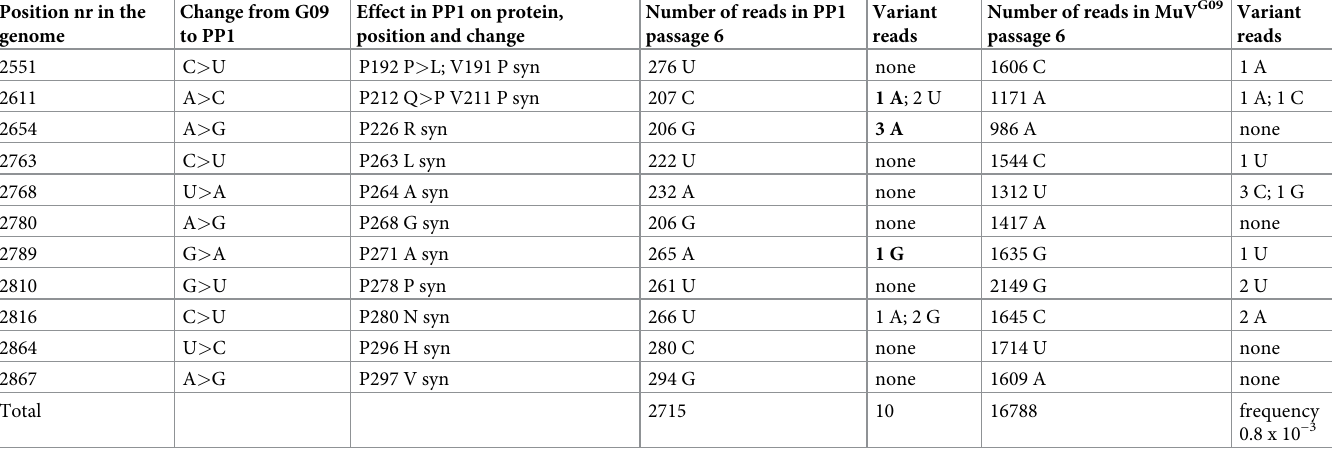
Table 1. Stability of the unique mutations in RNA extracted from semi-purified MuV–PP1 virus after 6 passages on Vero cells. Position nr in the Change from G09 genome to PP1 single well and passaging the inoculum 4 times on Vero cells at low MOI. The reverse genetics system used ‘helper’ expression plasmids representing the authentic N, P and L genes of MuV G09 and a plasmid containing the consensus sequence of MuV G09 so that fowl pox virus mediated recombination between helper plasmids and the full length genome plasmid could not lead to potential sequence alterations. Out of the 5 plaque picks that were made in the pri- mary rescue wells transfected with a plasmid representing the full length genome of MuV G09 none were identical to the input cDNA clone sequence and a combined total of 18 mutations were observed. Four retrieved viruses had one or two mutations but one virus rMuV G09 PP1 (abbreviated as PP1) had 11 mutations in the V/P gene (Table 1) between nucleotides 2551 and 2867 spacing mutations on the average 32 nt from each other. This area encodes the C ter- minal end of the V protein and part of the more conserved C-terminal domain of the P protein in MuV. Nine mutations were synonymous and two of the PP1 mutations led to amino acid changes at position 192 (P > L) and 212 (Q > P) in the P protein. Both mutations were synony- mous in the overlapping V protein reading frame. Rescue was also attempted from a plasmid into which the EGFP gene had been inserted between the V/P and M genes of mumps virus MuV G09 . Similarly, out of the 7 plaque picked viruses none had a nucleotide sequence identical to the original plasmid. Six out of the 7 viruses carried in toto 9 mutations (8 non-synonymous replacements and one A insertion in the poly-adenylation signal in the F gene). However, one plaque picked virus rMuV G09 EGFP (3)PP2 virus (abbreviated here as PP2) had 32 mutations in two clusters in the N gene (Table 2). One cluster contained 13 mutations between nt 607 and 860 distancing mutations by on average 21 nucleotides. This area encodes a relatively conserved part of the N protein of MuV. The second cluster contained 19 mutations between nucleotides 1225 and 1558 with an average spacing of 18 nucleotides. This encodes part of the relatively variable C terminal tail of the N protein of MuV. In PP2 almost all the mutations (31/32) were synonymous with the exception of a single conservative V > A mutation at position 460 of the N protein. None of the mutations observed in PP1 and PP2 were observable as minor peaks in sequencing chromato- grams of the sequencing reactions carried out on the clinical material. The sets of mostly syn- onymous mutations observed in these viruses in the N and V/P genes were also not present as linked variations in sequence of the mumps virus genotypes in the databanks. No clusters of